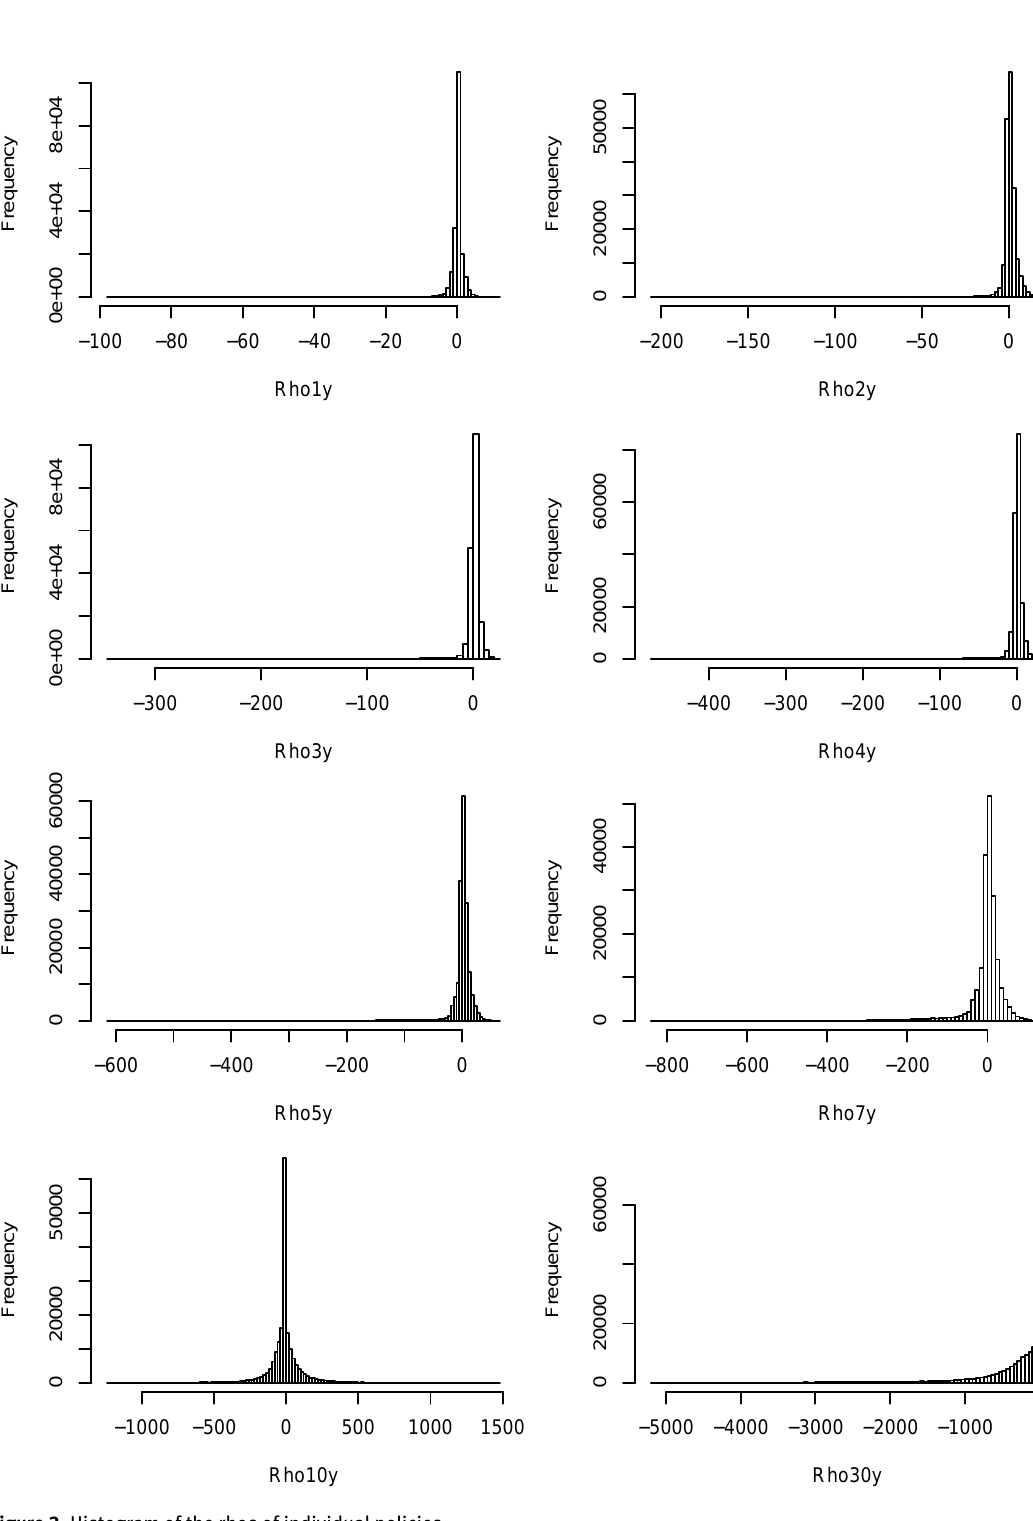
Figure 3: Histogram of the rhos of individual